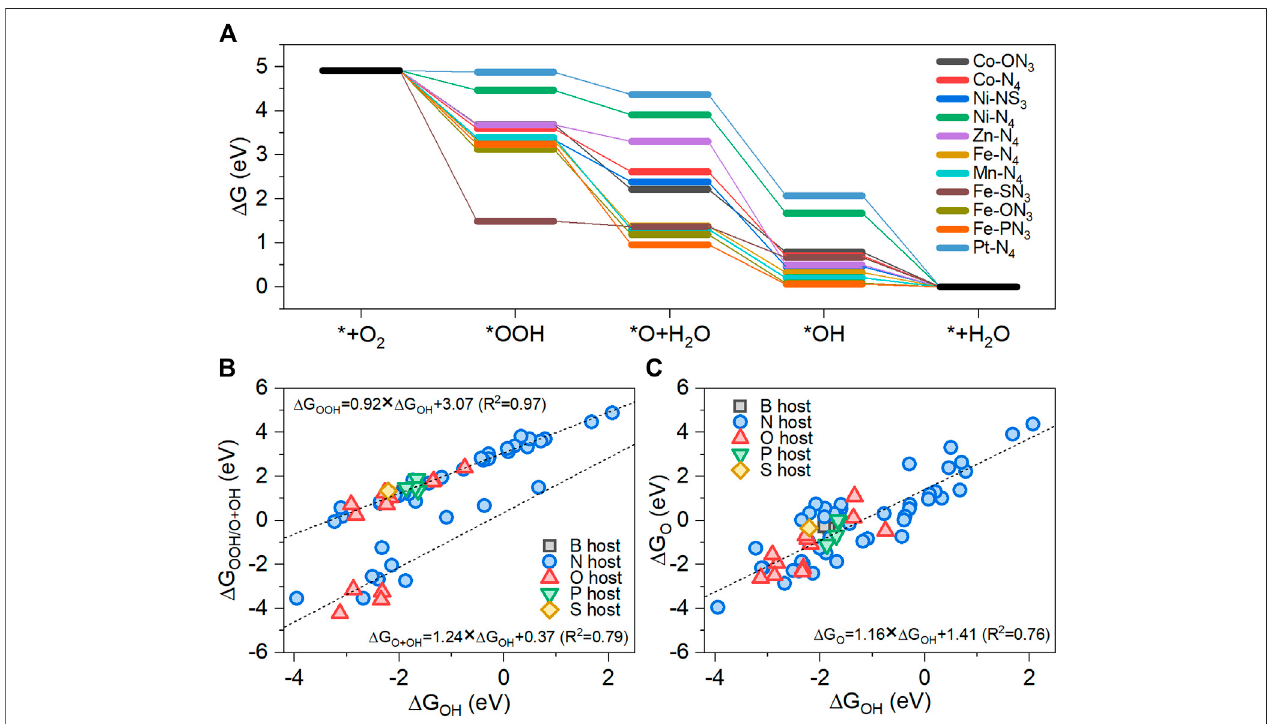
FIGURE3|(A) FreeenergychangesduringtheORRon11 M-YX 3 withpositivelimitingpotential.ThelinearadsorptionfreeenergyscalingrelationshipsoftheORR intermediates on the stable M-YX 3 structures: (B) OOH*/O*+OH* vs. OH* and (C) O* vs. OH*.